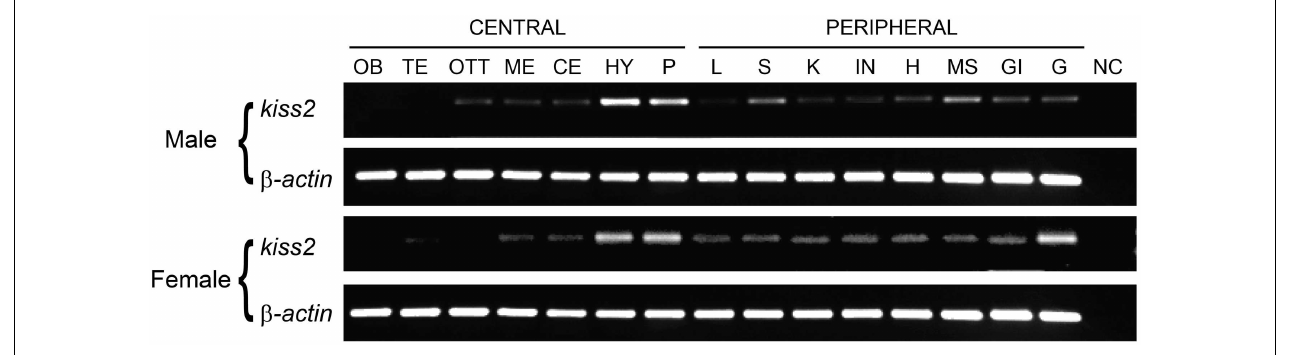
thalamus; ME, medulla; CE, cerebellum; HY, hypothalamus; P, pituitary; L, liver; S, spleen; K, kidney; IN, intestine; H, heart; MS, muscle; GI, gill; G, gonad; NC, negative